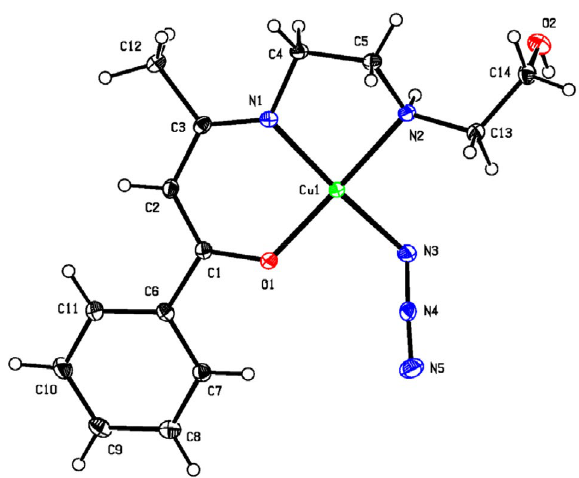
Fig. 2. The molecular structure of [CuL(N 3 )], 2 with labeling of se- lected atoms. tion geometry around the Cu(II) ions is four coordinated with a N3O donor set, N2O from the Schiff base ligand and one nitrogen from the azide ligand. The copper center